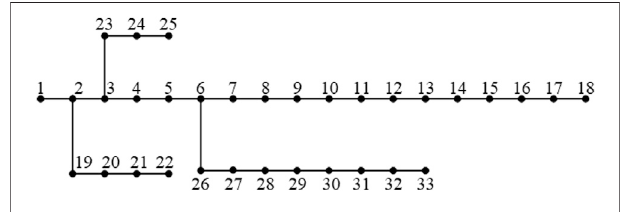
FIGURE 3 | IEEE-33 node distribution network (node-numbering diagram).